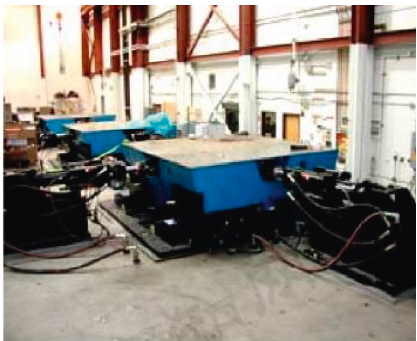
Figure 3: Seismic array of the University of Nevada, Reno.